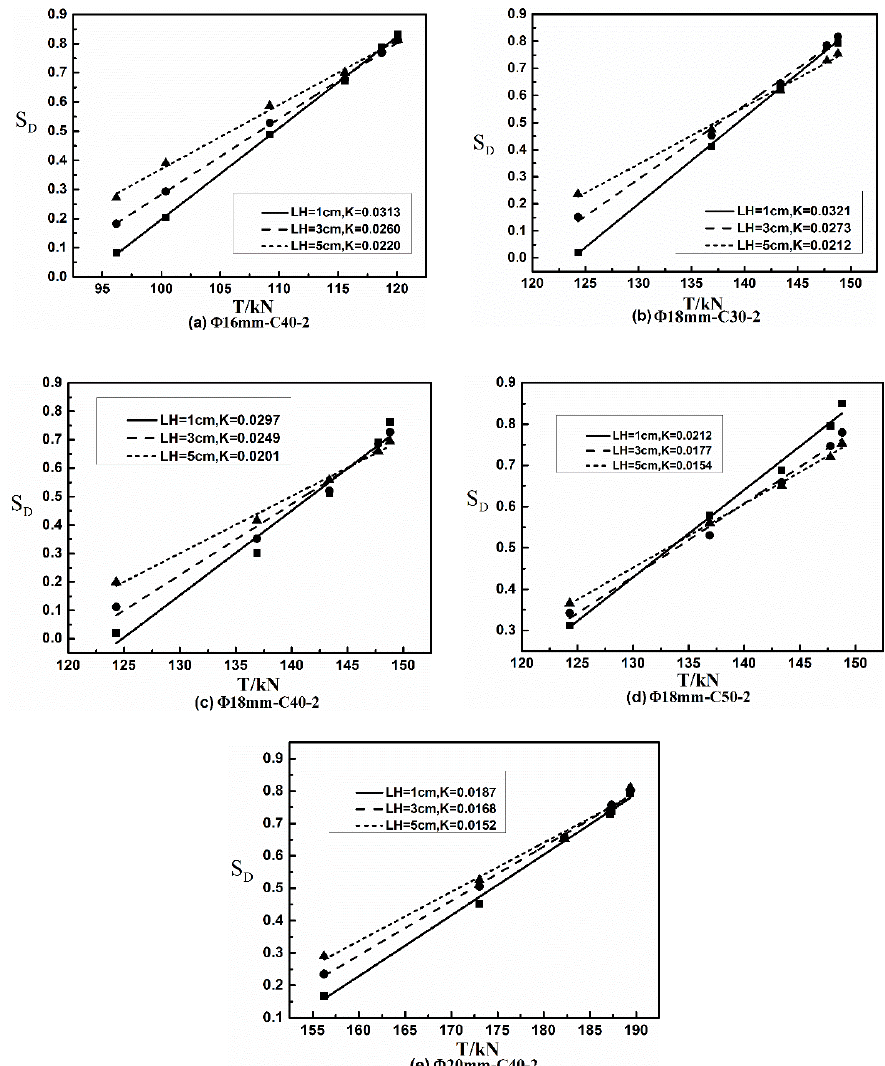
Figure 12. The linear portions of S D – T diagrams of different strength of outer concrete and